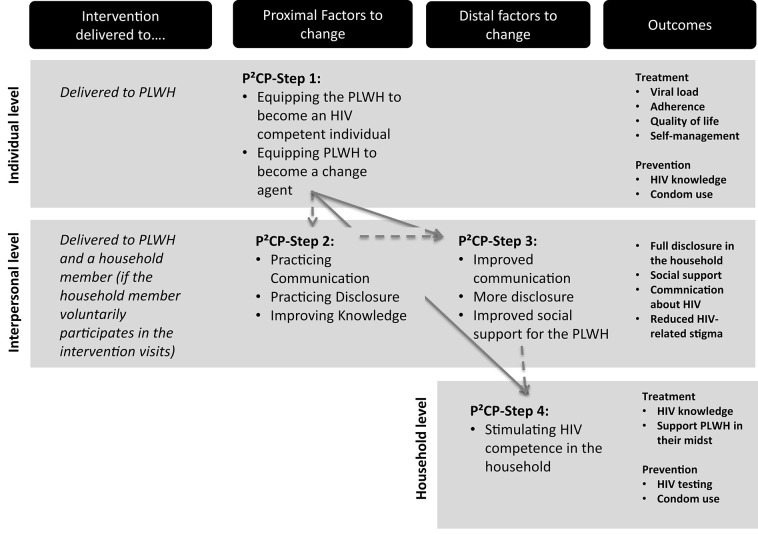
Pathways of change.